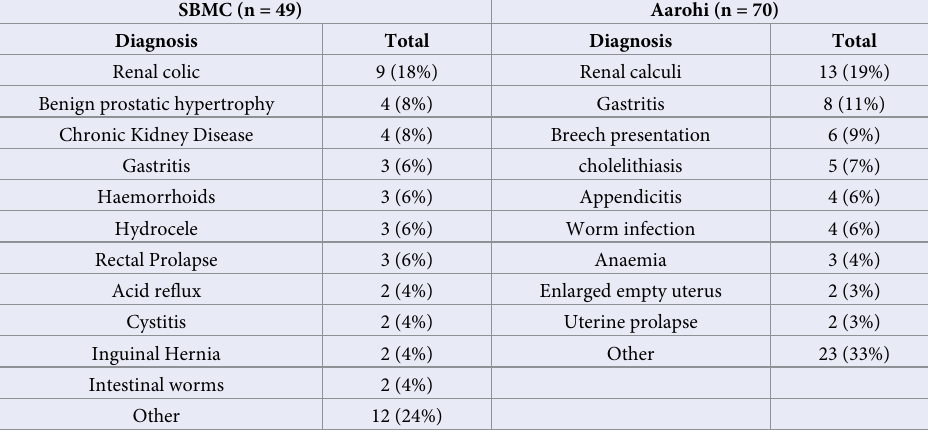
Table 4. Data from SBMC � and Aarohi �� on diagnosis recorded. SBMC (n = 49) Aarohi (n = 70) Diagnosis Total Diagnosis Total Renal colic 9 (18%) Renal calculi 13 (19%) Benign prostatic hypertrophy 4 (8%) Gastritis 8 (11%) Chronic Kidney Disease 4 (8%) Breech presentation 6 (9%) Gastritis 3 (6%) cholelithiasis 5 (7%) Haemorrhoids 3 (6%) Appendicitis 4 (6%) Hydrocele 3 (6%) Worm infection 4 (6%) Rectal Prolapse 3 (6%) Anaemia 3 (4%) Acid reflux 2 (4%) Enlarged empty uterus 2 (3%) Cystitis 2 (4%) Uterine prolapse 2 (3%) Inguinal Hernia 2 (4%) Other 23 (33%) Intestinal worms 2 (4%) Other 12